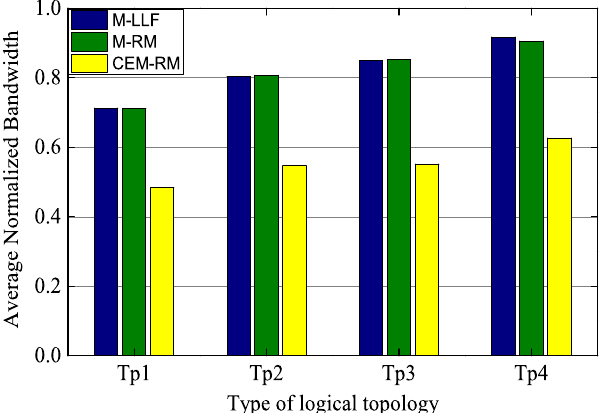
Figure 8. Comparison of average normalized